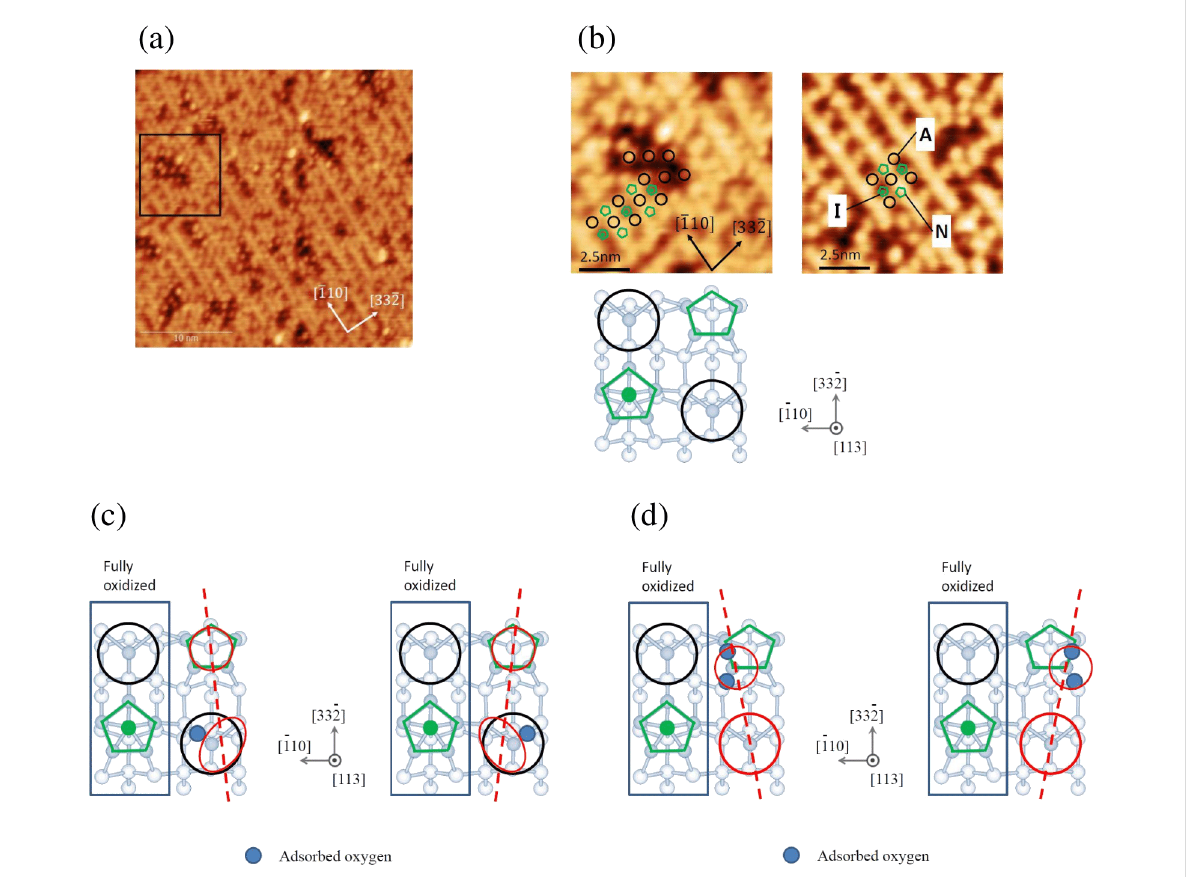
Figure 8: (a) High-resolution STM image of Si(113)-(3 × 2) upon oxidation at an oxygen pressure of 2.6 × 10 − 5 at 820 K, corresponding to the oxida- tion regime. Total oxygen exposure is 3 L. (b) Magnified image (left) taken at the square in (a) and the corresponding image of a clean Si(113)-(3 × 2) surface at the same scale (right). Here, A represents the adatom site, I represents the i-pentamer site with an interstitial silicon atom, and N repre- sents the n-pentamer site with no interstitial silicon atom. Two types of the possible models (c, d) for the tilted paiers (Pair 1 and Pair 2), as observed in Figure